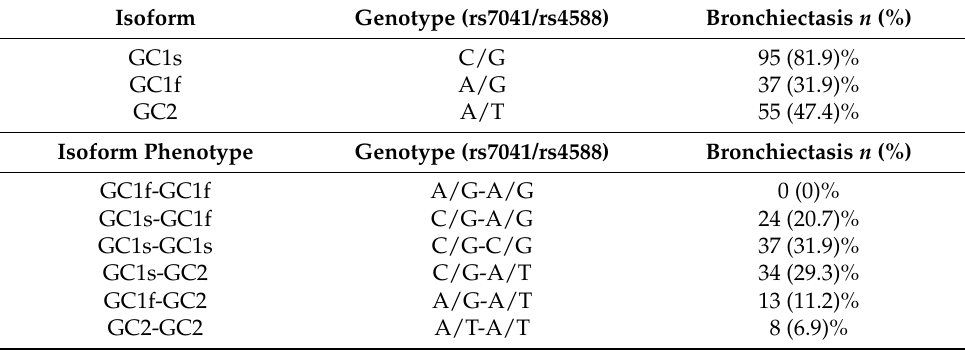
Table 2. Isoforms of vitamin D binding protein (DBP) in bronchiectasis